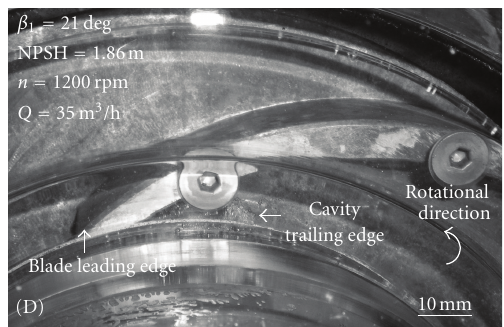
Figure 15: Illustration of cavitation for the blade leading edge angle of 21deg and NPSH equal to